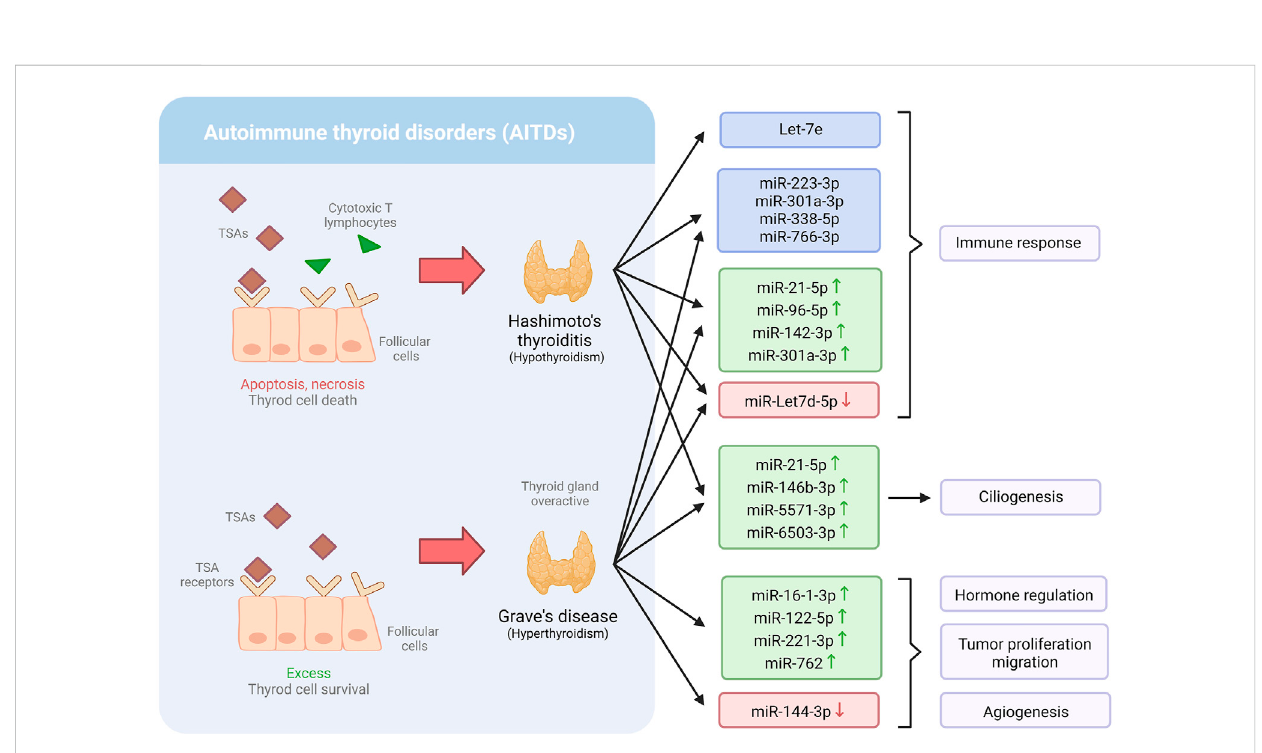
2019). According to the World Health Organization (2021), 1.5 million deaths were estimated to be caused directly by diabetes, placing this disease as the ninth leading cause of death worldwide. Given the high occurrence of DM and its complication,